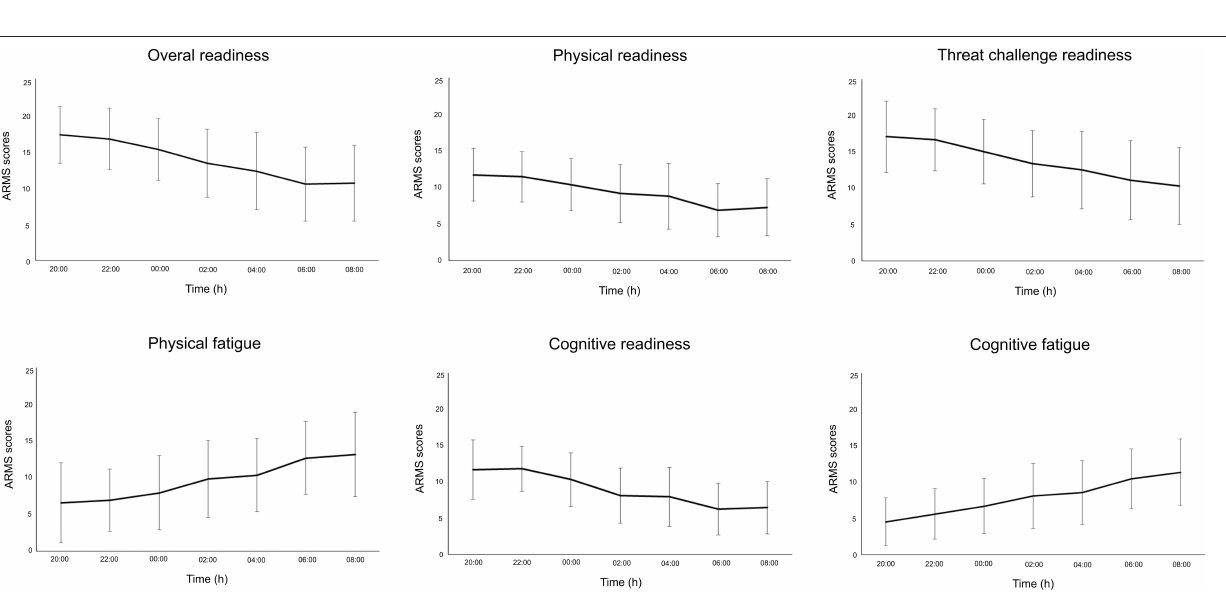
Frontiers in Psychology | www.frontiersin.org